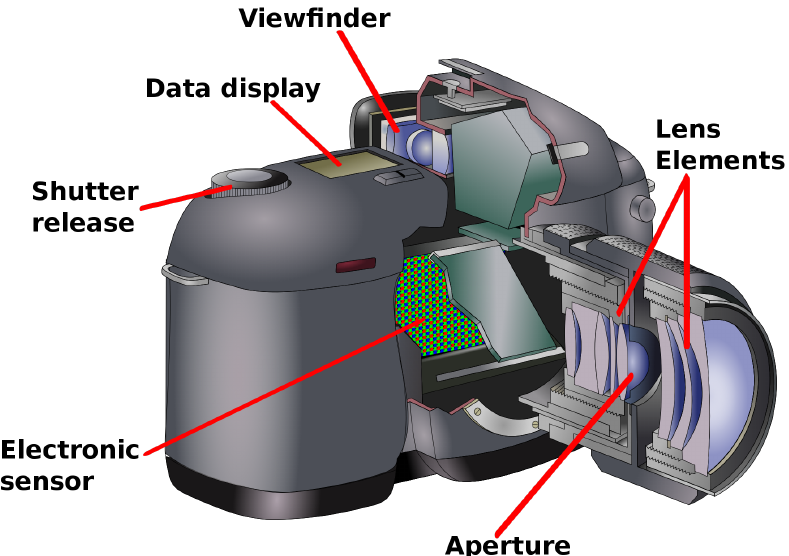
Figure 3. Diagram of a single-lens reflex camera with basic labels. Based on Reflex camera labels.svg. The author of the original base image is Jean François WITZ. By Astrocog—Own work, CC BY-SA 3.0, https://commons.wikimedia.org/w/index.php?curid=29334470, accessed on 31 December 2021. The distortion model is shown in Figure 4.